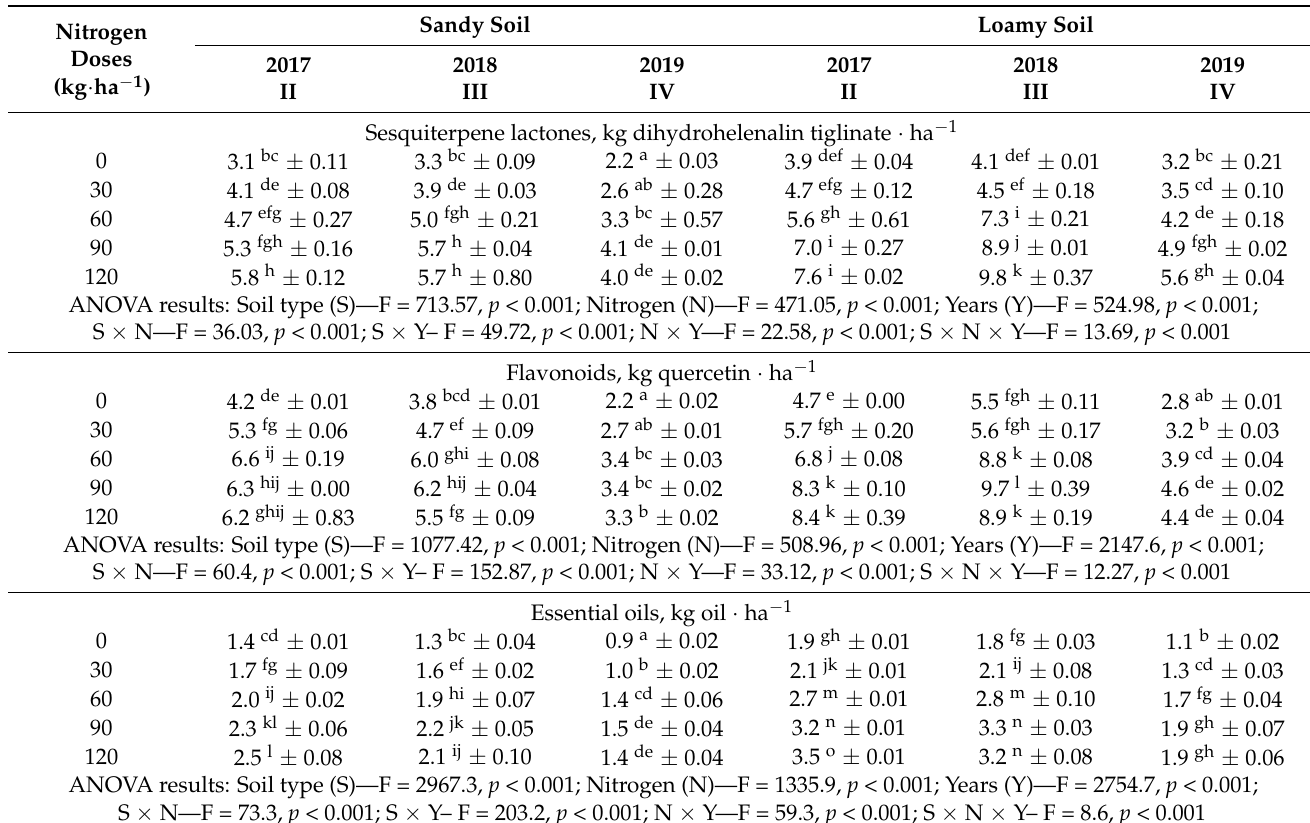
Table 3. The yield of sesquiterpene lactones, flavonoids, and essential oil per ha − 1 depending on the experimental